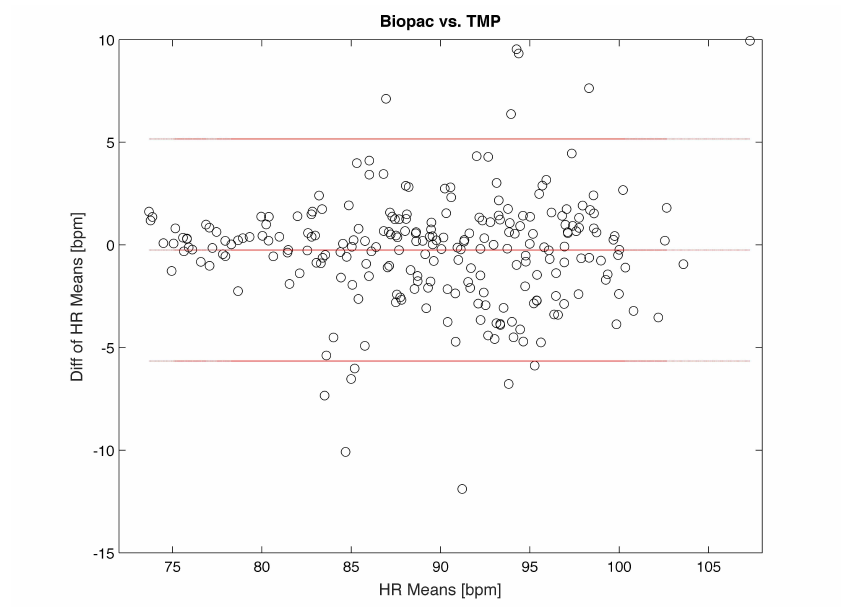
Figure 9. Bland-Altman plots of the Heart Rate value extracted from the TMP signal compared with the one calculated from Biopac